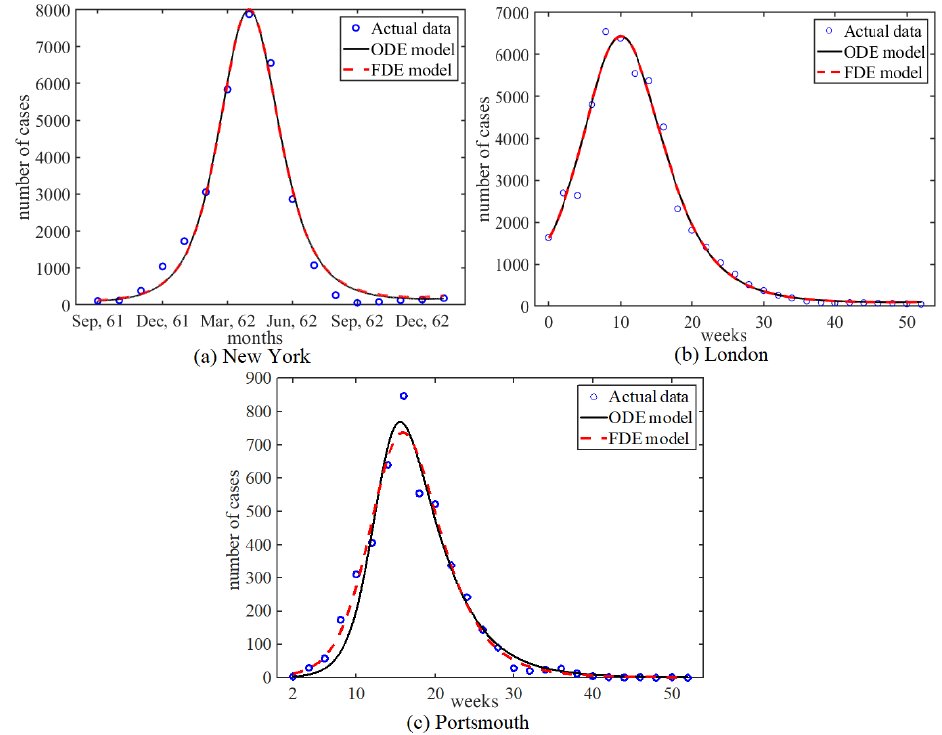
Figure 5. Simulations of ODE and FDE fitted to measles epidemics in the pre-vaccination era for ( a ) New York, ( b ) London, and ( c ) Portsmouth using the parameter values from Table A4. ODE and FDE models give similar fitting in ( a ) and ( b ) but FDE model performs better than ODE model in ( c ). The estimates of α are 0.999999999524, 0.999999999614, and 0.875784505546 for New York,